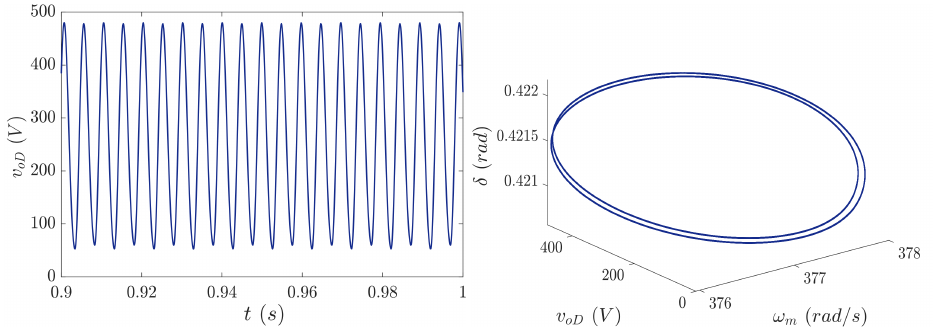
Figure 15. Period-doubling oscillations at P 0 = 3.86 p.u.